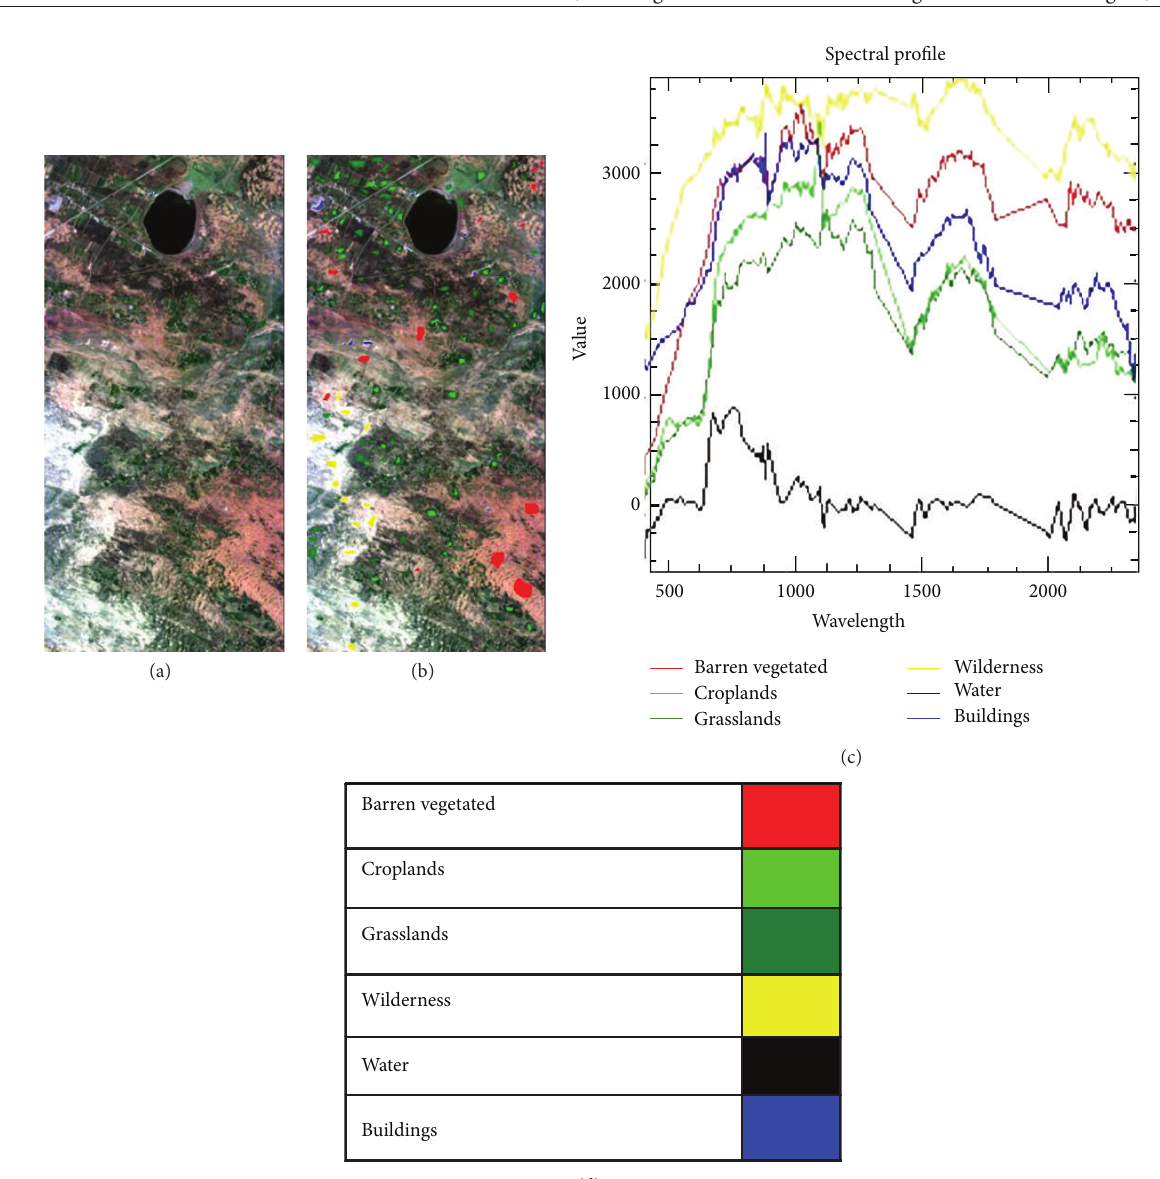
Figure 4: The T-1 original image of the study area. (a) The original Hyperion hyperspectral image (bands 29, 20, and 11). (b) The training sites overlay of original image. (c) The spectral curves of 6 kinds of major categories feature representing the land cover types of study area. (d) The thematic maps definition of 6